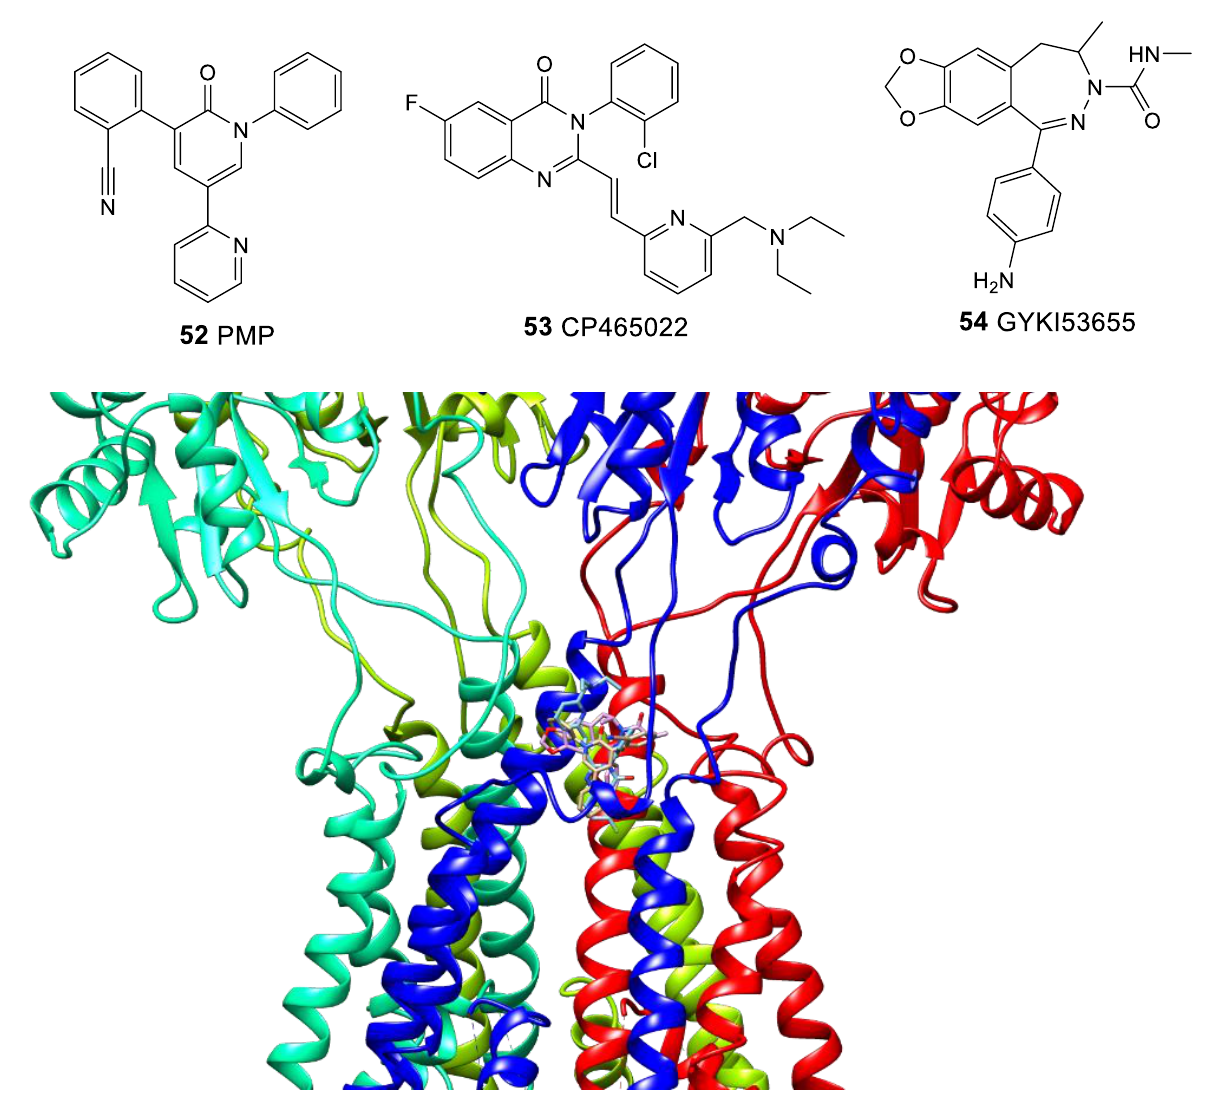
Figure 10. Comparison of the binding modes of negative allosteric modulators GYKI53655 ( 54 , pink, PDB: 5L1H), CP465022 ( 53 , cyan, PDB: 5L1E), and perampanel ( 52 , beige, PDB: 5L1F) at the interface between LBD and TMD of GluA2. For clarity, among the aligned receptor subunits, only the subunits for the perampanel structure are shown in blue, mint, spring green, and red, and only one out of four symmetrical binding positions are shown for each ligand.